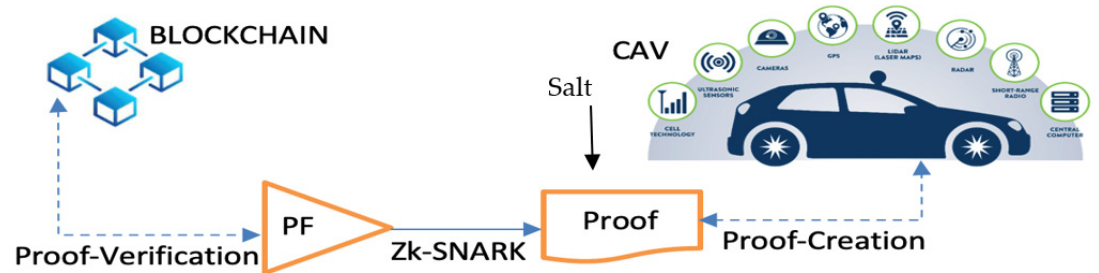
Figure 1. Conceptual Diagram of Proposed System.